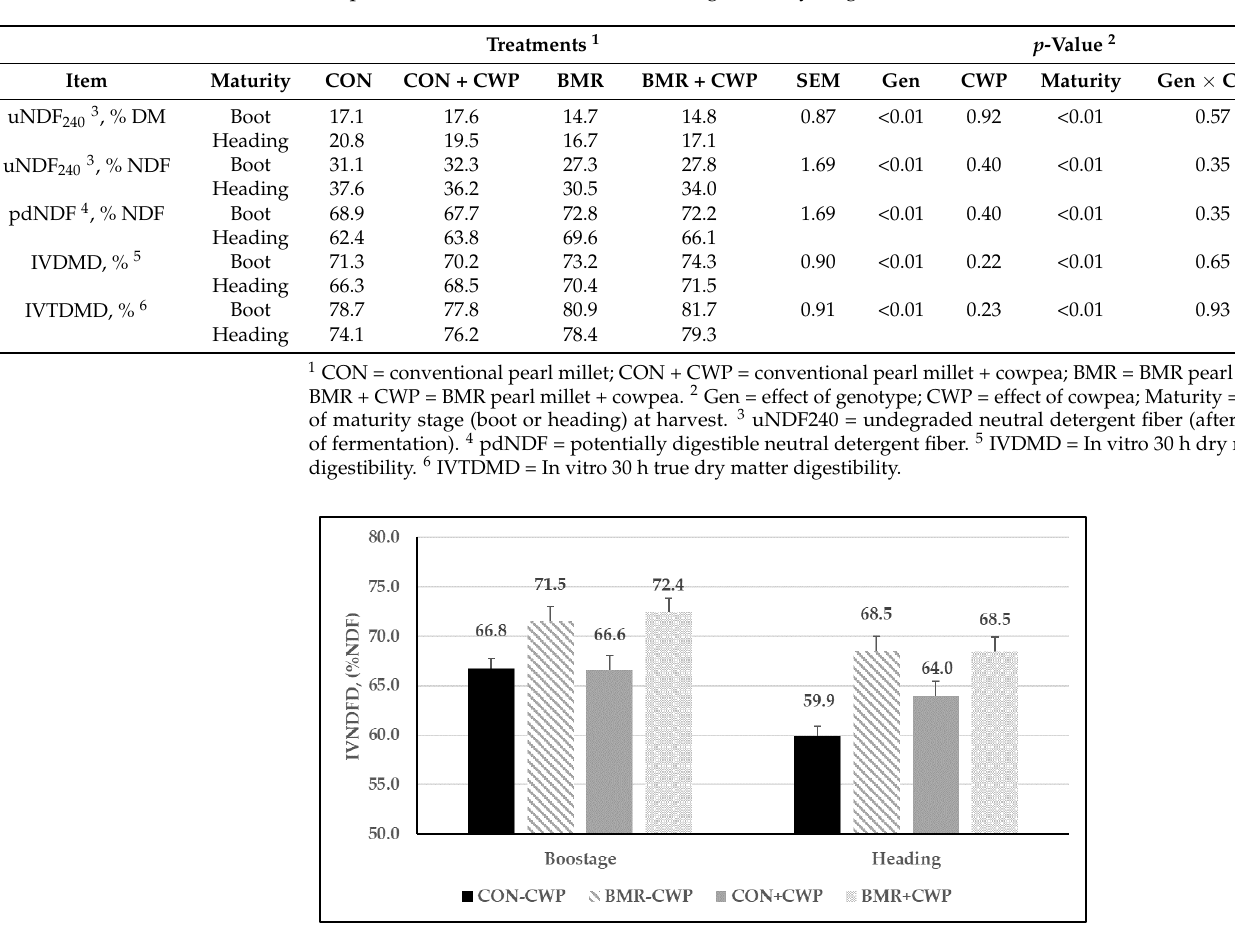
Table 4. Undigestible NDF and in-vitro DM digestibility of pearl millet genotypes mixed or not with cowpea and harvested at boot or heading maturity stages (Trial 2).